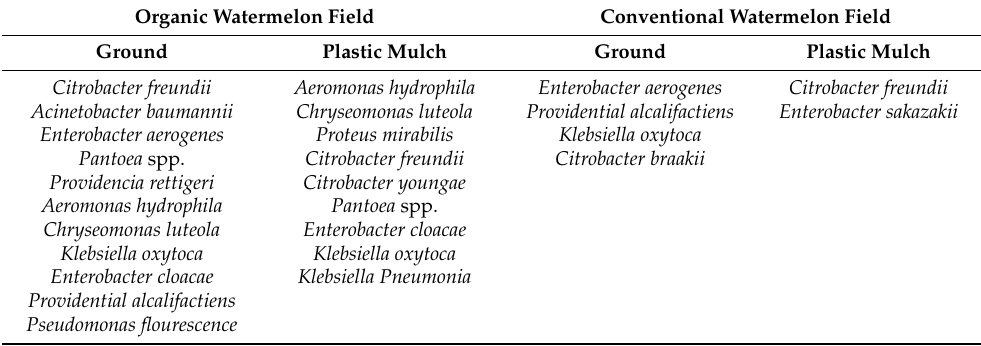
Table 1. Enterobacteriaceae strains isolated from watermelons in the TSU farm, TN. Organic Watermelon